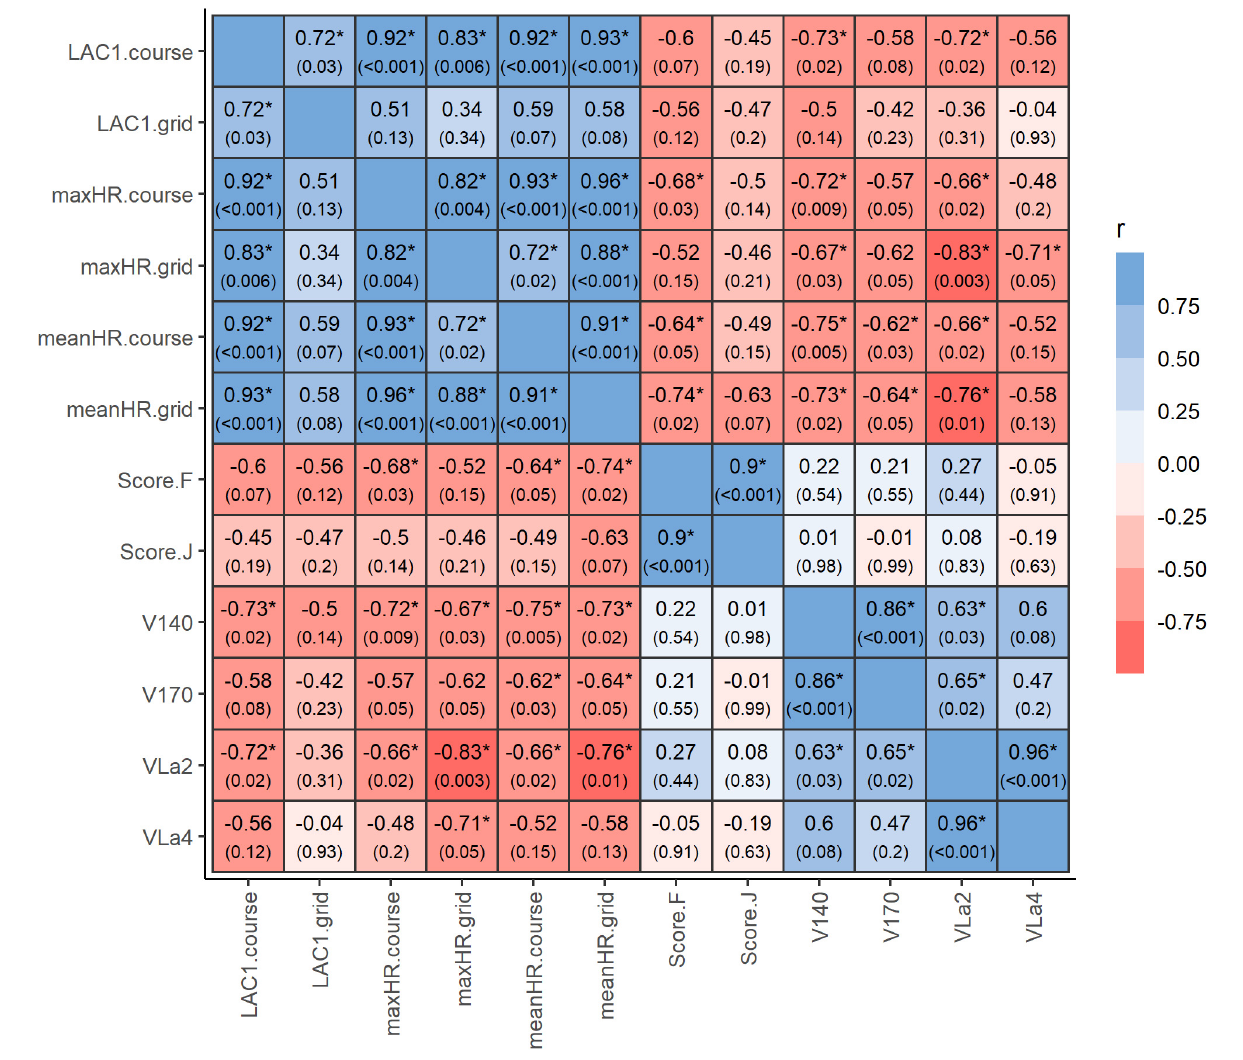
FIGURE 4 | Correlation between performance parameters. Correlation between performance parameters derived from the standardized incremental field test (SET track ) and heart rate and blood lactate in response to the standardized show-jumping course (SET course ) and grid exercise (SET grid ). The background color of each panel indicates the strength of the correlation between two variables (red indicates negative, blue indicates positive correlation). The correlation coefficients and P -values (in parenthesis) are also shown for each pair of variables. Asterisks indicate significant correlations. LAC1.course, blood lactate concentration immediately after SET course ; LAC1.grid, blood lactate concentration immediately after SET grid ; maxHR.course, maximum heart rate during SET course ; maxHR.grid, maximum heart rate during SET grid , meanHR.course, mean heart rate during SET course ; meanHR.grid, mean heart rate during SET grid ; Score.F, Score for resistance to fatigue; Score.J, Score for jumping technique; V140, velocity at a heart rate of 140 bpm; V170, velocity at a heart rate of 170 bpm; VLa2, velocity at a blood lactate concentration of 2 mmol/L; VLa4, velocity at a blood lactate concentration of 4 mmol/L; r, pearson correlation